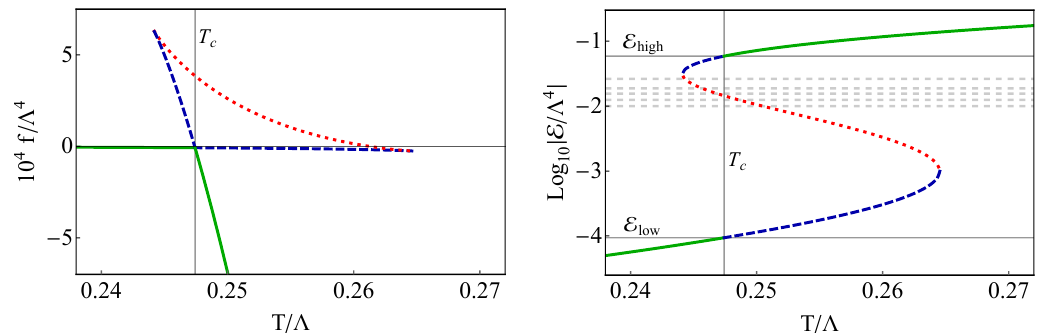
Figure 1 . Free energy density (left) and energy density (right) versus temperature for the gauge theory dual to (2.1). The thermodynamically preferred phase is shown in solid green. In dashed blue we show the locally stable but globally unstable region. The locally unstable region, the so-called spinodal region, is shown in dotted red. The grey vertical lines indicate T c = 0 : 247(cid:3). The solid horizontal grey lines correspond (from top to bottom) to the energy densities (2.5). The dashed horizontal grey lines correspond (from top to bottom) to the energy densities fE 1 ; E 2 ; E 3 ; E 4 ; E 5 g given in